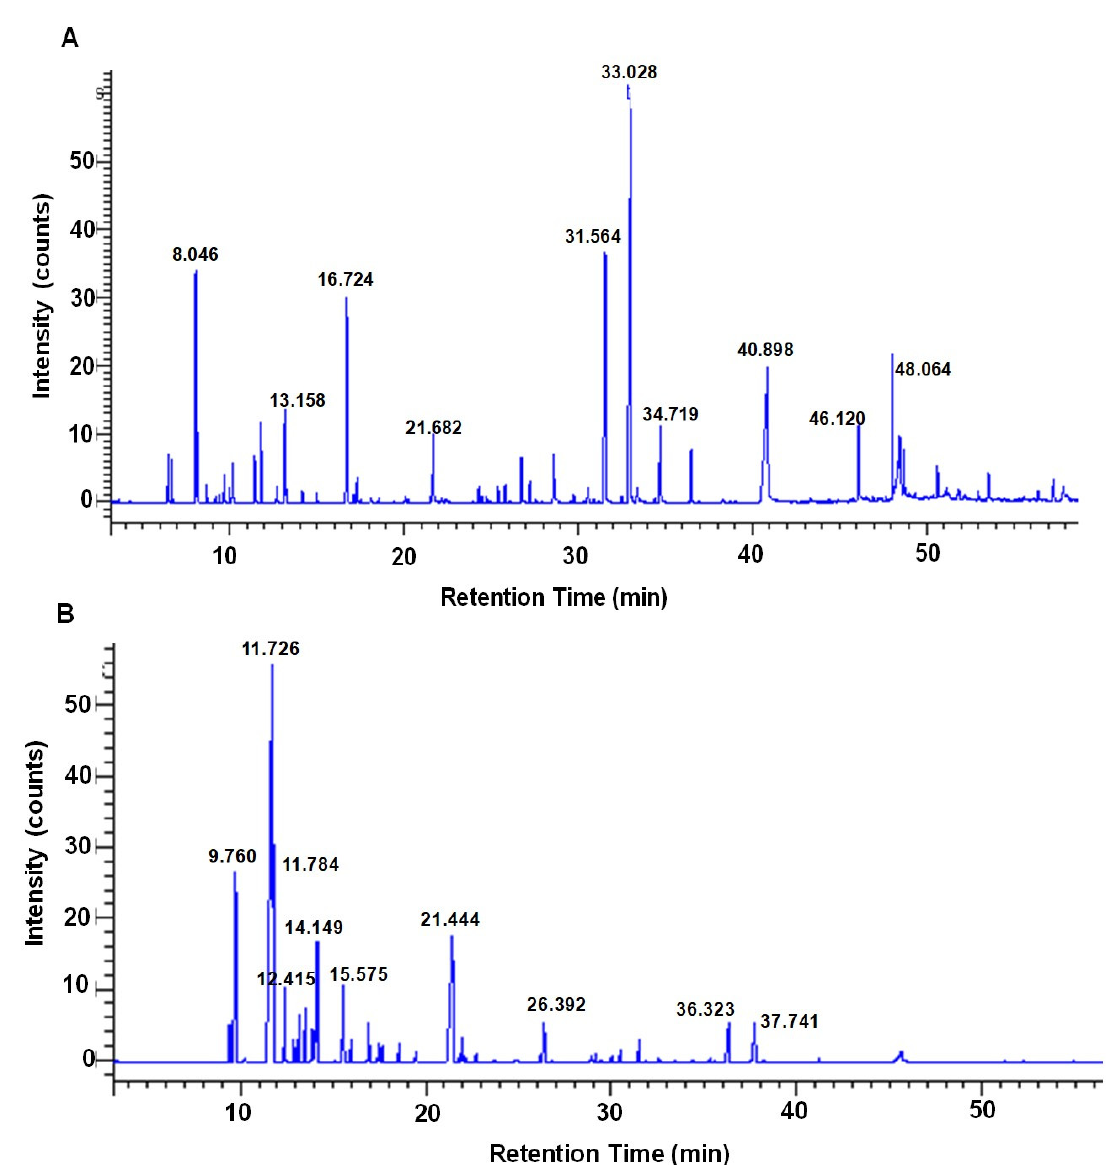
Figure 1. GC/MS analysis chromatogram of nutmeg. The major compounds are indicated in the high peak area (%) Figure 1. GC / MS analysis chromatogram of nutmeg . The major compounds are indicated in the high peak area (% ) repre- representative chromatogram, with 0 to 60 min retention time-8.046 (sabinene), 13.158 (cis-14-thujanol), 16.724 (4-terpineol), sentative chromatogram, with 0 to 60 min retention time - 8 . 046 ( sabinene ) , 13 . 158 ( cis - 14 - thujanol ) , 16 . 724 ( 4 - terpineol ) , 21.682 (safrene), 31.564 (myristicin), 33.028 (elemicin), 34.719 (methoxyeugenol), 40.898 (tetradecanoic acid), 46.120 21 . 682 ( safrene ) , 31 . 564 ( myristicin ) , 33 . 028 ( elemicin ) , 34 . 719 ( methoxyeugenol ) , 40 . 898 ( tetradecanoic acid ) , 46 . 120 ( n - hexa- decanoic acid ) and 48 . 064 ( decanoic acid, 2 - oxo - , methyl ester )- obtained from crude extract ( A ) , and 9 . 760 ( α - pinene ) , 11 . 726 (n-hexadecanoic acid) and 48.064 (decanoic acid, 2-oxo-, methyl ester)-obtained from crude extract ( A ), and 9.760 ( α - ( sabinene ) , 11 . 784 ( β - pinene ) , 12.415 ( β - myrcene ) , 14 . 149 ( β - phellandrene ) , 15 . 575 ( γ - terpinene ) , 21 . 444 ( 4 - terpineol ) , 26 . 392 pinene), 11.726 (sabinene), 11.784 ( β -pinene), 12.415 ( β -myrcene), 14.149 ( β -phellandrene), 15.575 ( γ -terpinene), 21.444 ( 1,3 - benzodioxole, 5 -( 2 - propenyl )- , 36 . 323 ( myristicin ) and 37 . 741 ( cis - asarone )- obtained from essential oil ( B ) . (4-terpineol), 26.392 (1,3-benzodioxole, 5-(2-propenyl)-, 36.323 (myristicin) and 37.741 (cis-asarone)-obtained from essential oil ( B